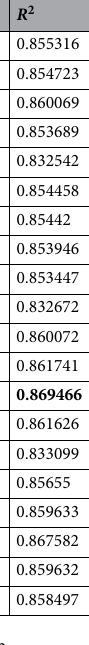
2 Table 1. R values over the test set w.r.t. (cid:31) 9 and (cid:31) 24 values, resulting from 100000 steps of training. Values for the best model are in